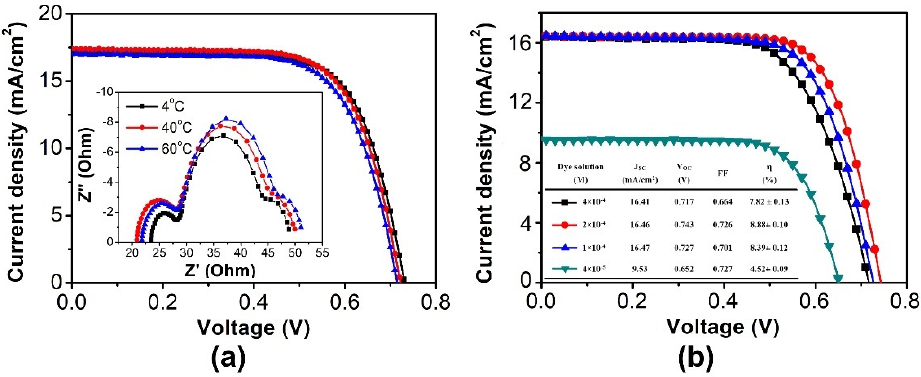
Figure 6. ( a ) The J-V curve with different dye soaking temperatures and the insert plot (Nyquist plot of EIS analysis). ( b ) The J-V curve of DSSC module with TiO 2 electrode dye-soaking in different dye concentrations with detailed performance data.